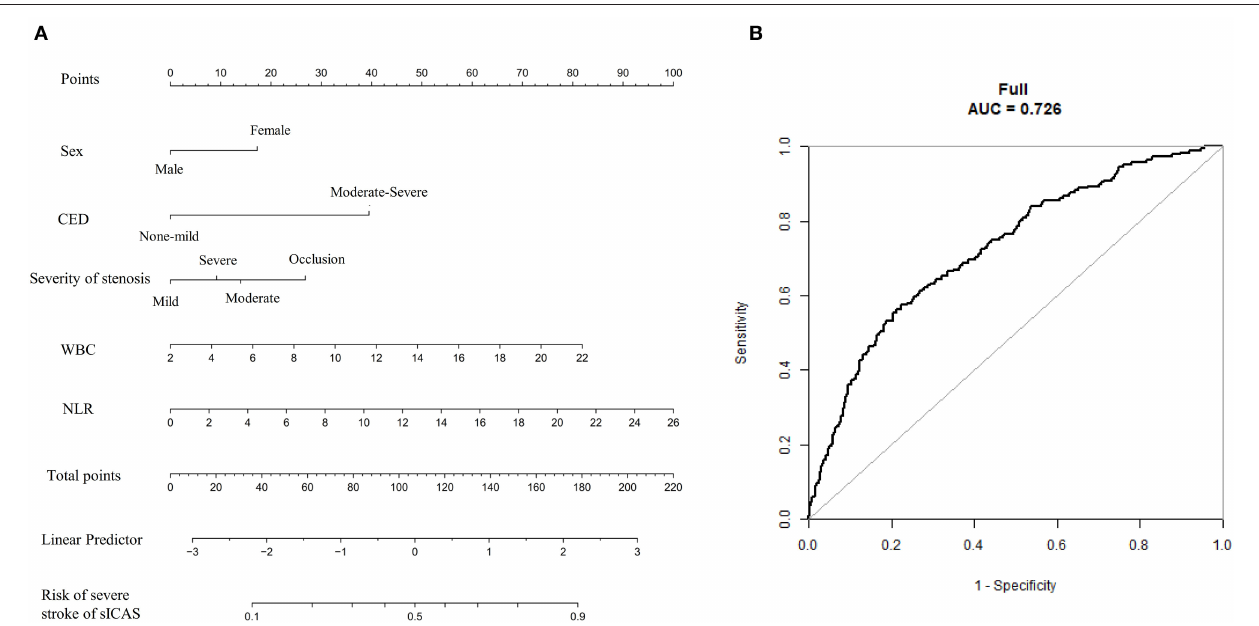
FIGURE 5 | The nomogram for predicting the severity of sICAS patients. (A) The nomogram for predicting the risk of severe neurological deficit of sICAS patients. (B) The ROC curve of the nomogram. The predictors were chosen based on the results of multivariate logistic regression in Model 1. Each selected factor was shown by a line in the nomograms. sICAS, symptomatic intracranial atherosclerotic stenosis; CED, cerebral edema; WBC, white blood cell; NLR, neutrophil-to-lymphocyte ratio; ROC, receiver operating characteristic; AUC, area under the curve.